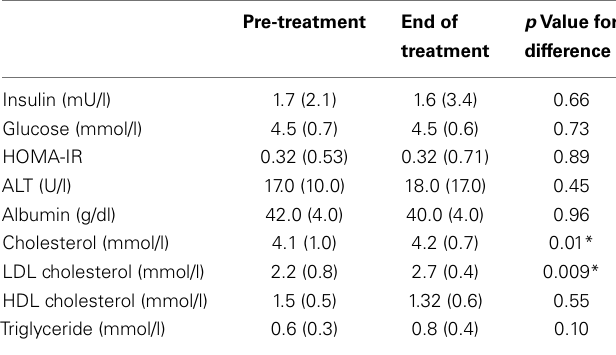
Table 3 | Median (interquartile range) pre-meal markers of insulin sensitivity, liver function, and lipid profile has been shown for all